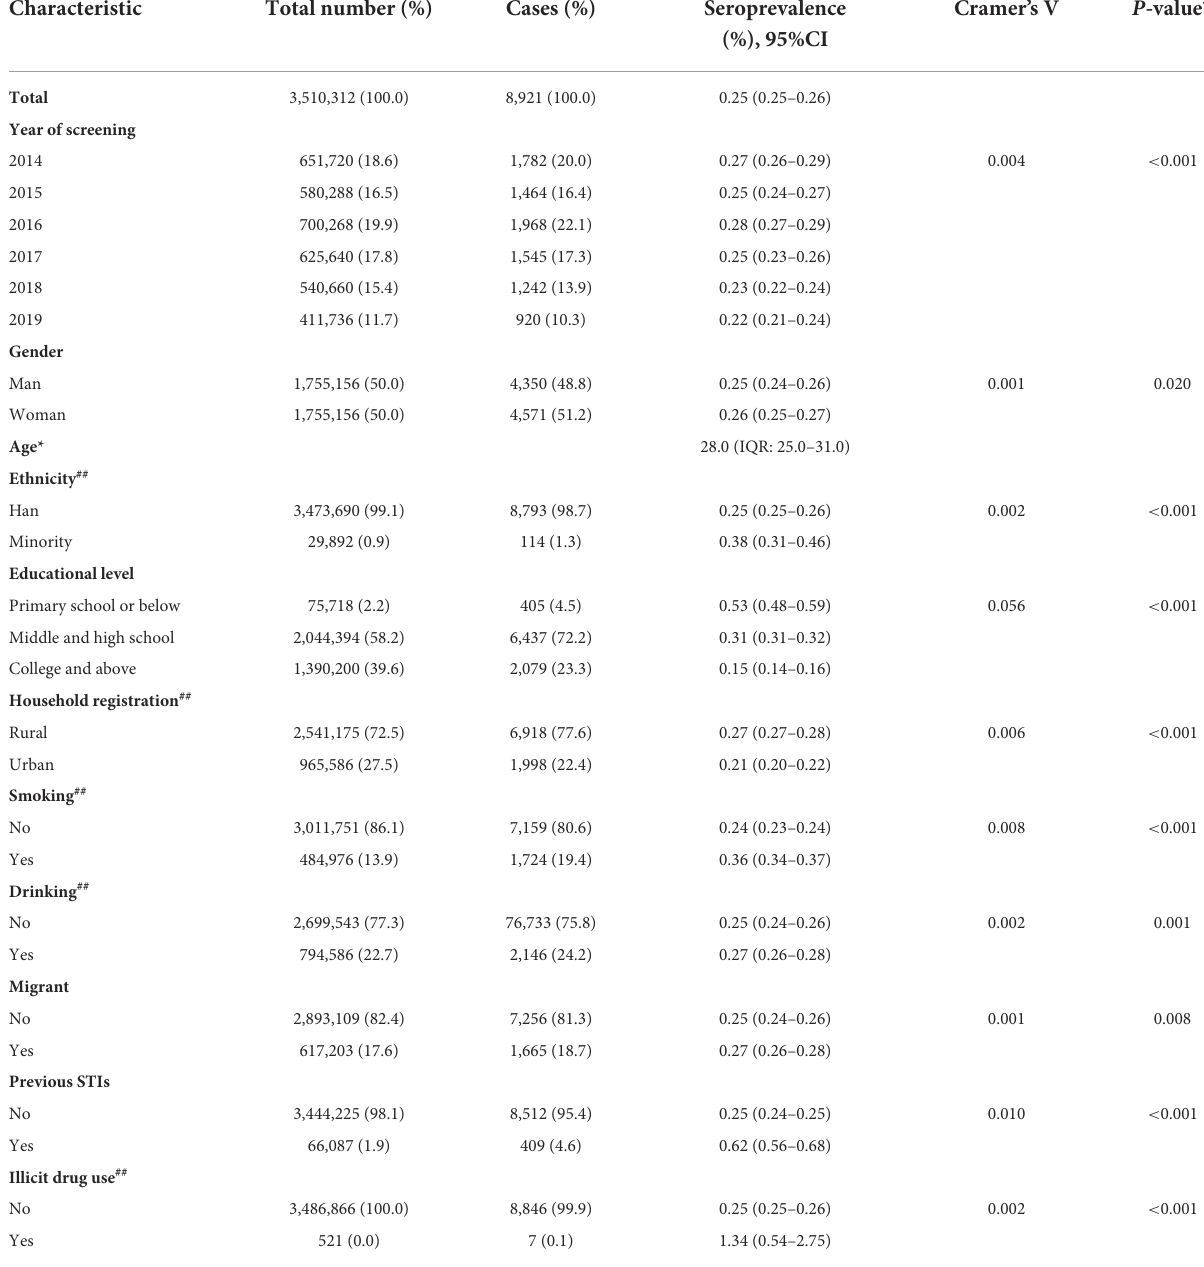
TABLE 1 Individual-level factors of heterosexual married individuals who participated in National Free Preconception Health Examination Project in Guangdong Province, China during 2014–2019 ( N = 3,510,312). Characteristic Total number (%) Cases (%)